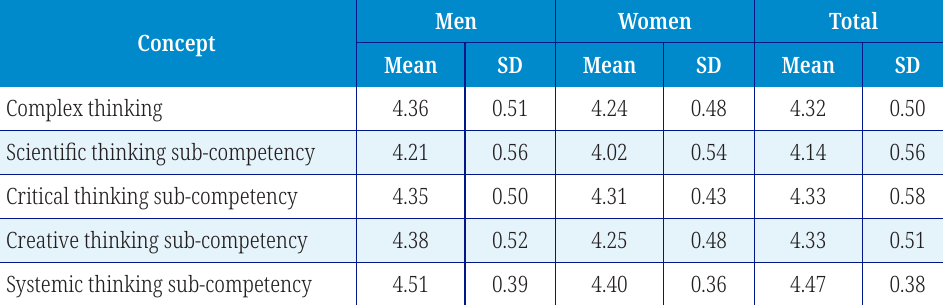
Table 3. Complex thinking: means and standard deviations